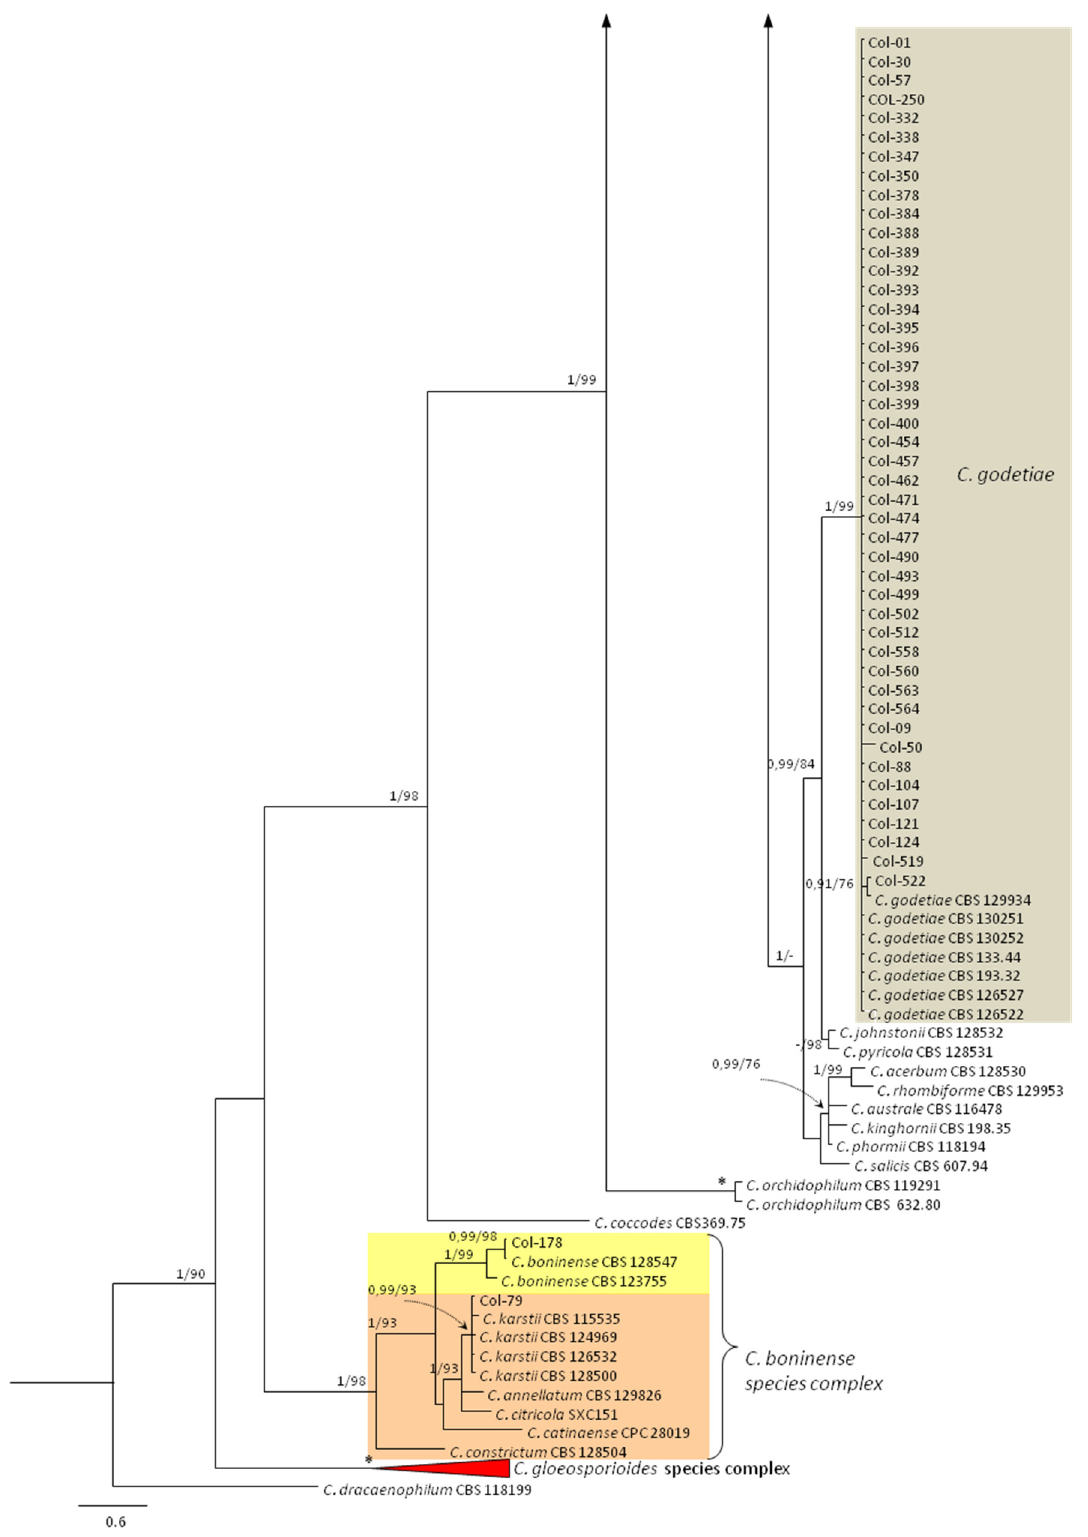
Figure 3. Phylogenetic tree resulting from Bayesian analysis using the combined ITS and TUB2 sequence alignments of Colletotrichum acutatum , C. boninense , and C. gloeosporioides species complexes. Bayesian posterior probabilities (PP, > 0.9) and bootstrap support values (MP, (BS) > 70%) of maximum parsimony analysis are shown in the nodes (PP/MP). The asterisk (*) indicates full support (1/100). Colletotrichum dracaenophilum (CBS 118199) was used as outgroup.